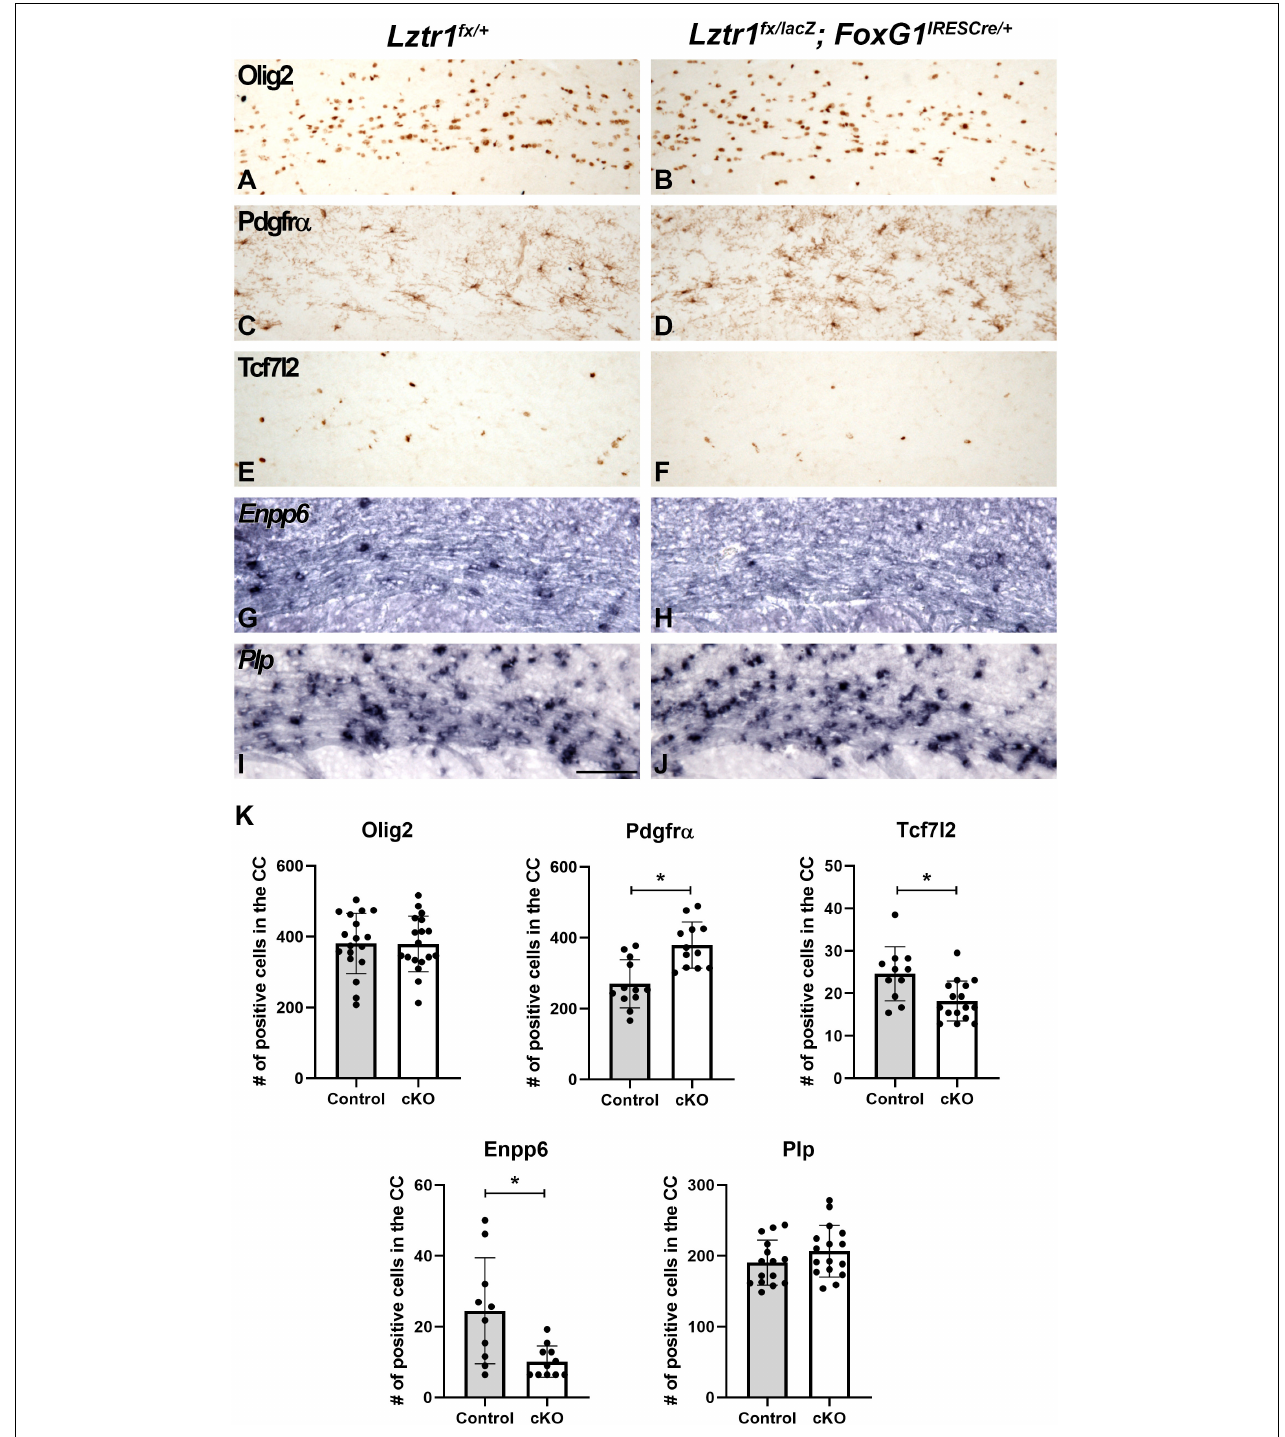
FIGURE 3 | Loss of Lztr1 impacts distinct stages of oligodendrocyte maturation in the corpus callosum of postnatal animals at 1 month of age. Olig2 marks the entire oligodendrocyte lineage, and no difference between the number of Olig2 + cells is observed in controls (A) and cKOs (B) . The OPC marker Pdgfr α was increased in the corpus callosum in cKOs (D) compared to controls (C) . Tcf7l2 and Enpp6 expression observed in differentiating and newly formed oligodendrocytes (E,G) are decreased in cKOs (F,H) . The mature oligodendrocyte marker Plp appears similar in controls and cKOs (I,J) . Quantification of oligodendrocyte markers by the number of positive cells per field in the CC (K) . Scale bar = 100 µ m for (A–J) . The asterisk in (K) refers to a p < 0.05 as detected by Student’s t -test.